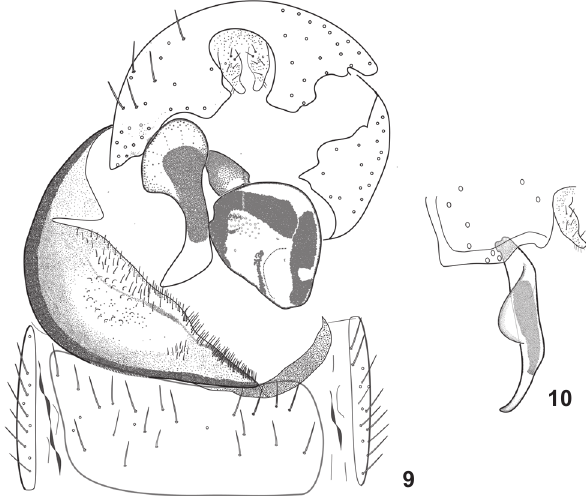
Figures 9-10. Illustrations of the male terminalia of Cyamops mathisi sp. nov. , paratype: (9) abdominal segments 5-7 and epandrium, ventral view; (10) left surstylus, lateral